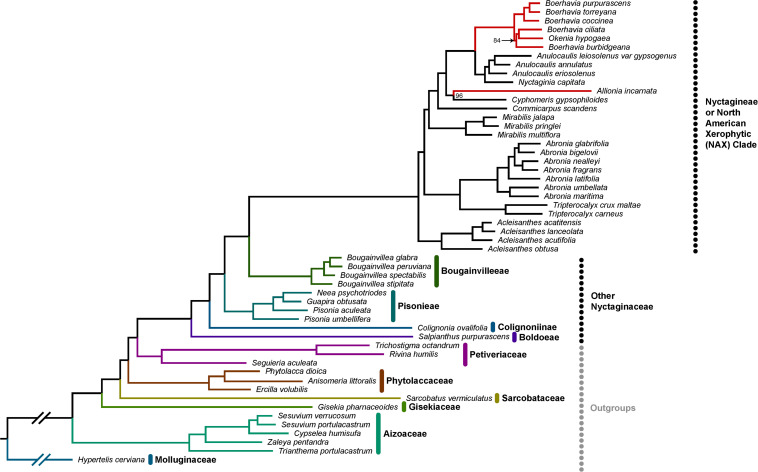
Phylotranscriptomic reconstruction of Nyctaginaceae. A maximum likelihood phylogeny of the Nyctaginaceae family and six outgroup families with previously uncertain topology. This tree is based on a concatenated super-matrix of 847 codon-aligned single-copy orthologs totaling 834,018 sites. All bootstrap support values are 100% except for the two nodes with values indicated, based on 200 bootstrap replicates. Within the Nyctagineae (identified as the North American Xerophytic clade by Douglas and Spellenberg, 2010), C4 lineages are denoted with red branches. The tree is rooted on Hypertelis cerviana and gapped branches here were shortened for visual convenience.